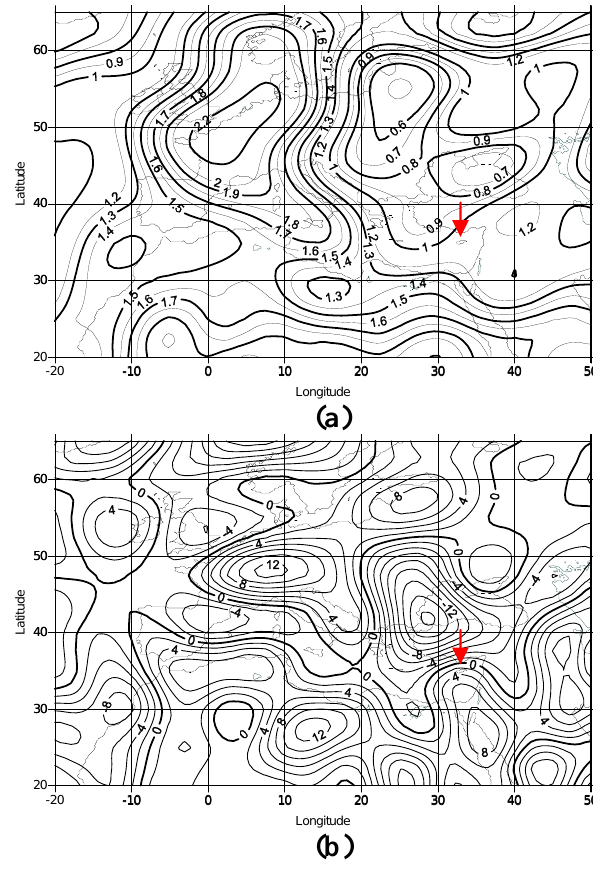
Fig. 4. (a) Geopotential height (solid lines, unit: gpm) and temperature (dashed lines, unit: K) at the isobaric level of 500hPa (a); (b) geopotential height (solid lines, unit: gpm) and relative vorticity (dashed lines, unit: x10 -5 s -1 ) at the isobaric level of 300hPa, at 0000 UTC 27 January 2008. The red arrow point to Cyprus area.